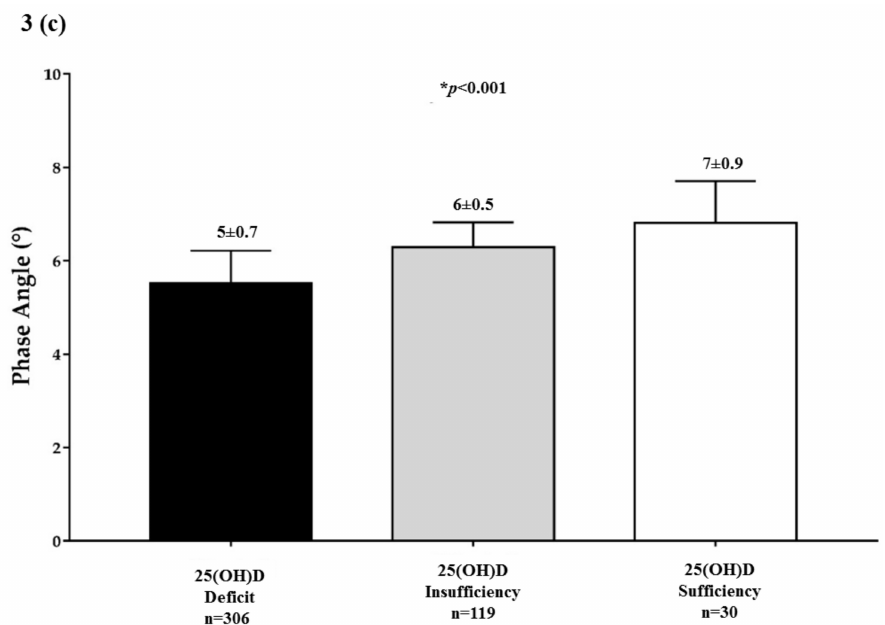
Figure 3. The body mass index (BMI) (Figure 3a), fat mass (FM) (Figure 3b) and phase angle (PhA) (Figure 3c) in the population study across 25(OH)D categories. A * p value denotes a significant di ff erence ( p < 0.05).